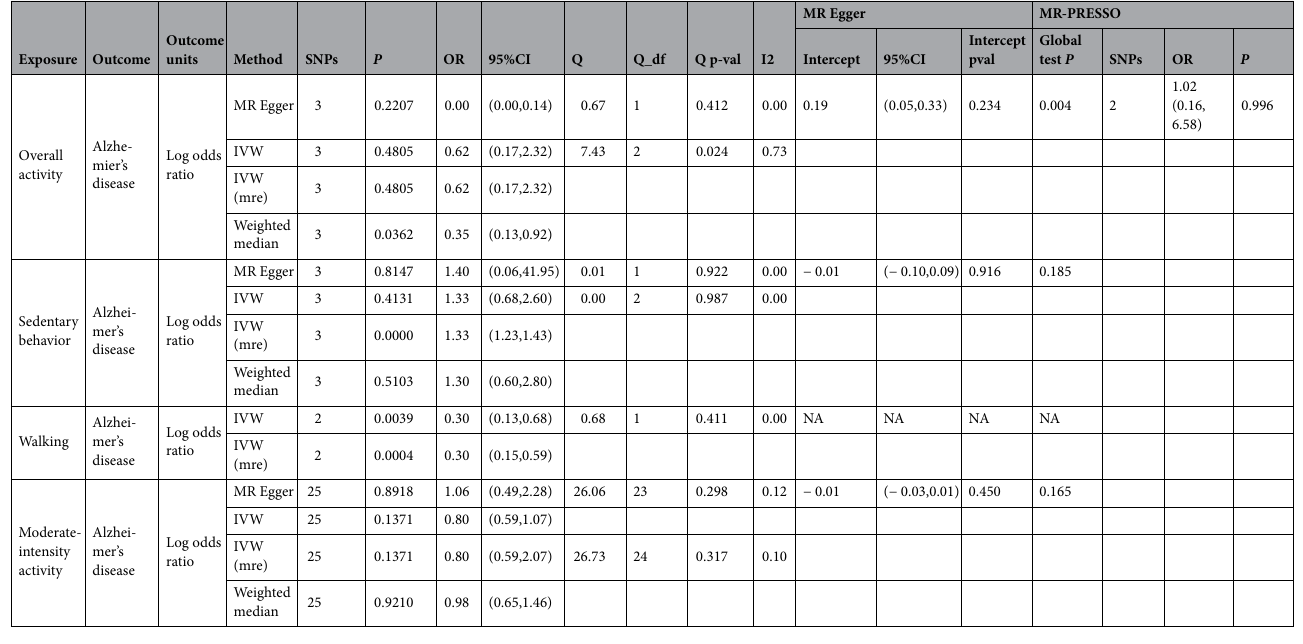
Table 3. MR Estimates for the effects of physical activity on AD risk in IGAP datasets. SNPs, single nucleotide polymorphisms; CI, confidence interval; OR, odds ratio; Q, Cochran Q statistics; IVW, inverse variance weighted; WM, weighted median; MR-Egger, Mendelian randomization-Egger; MR-PRESSO,MR pleiotropy residual sum and outlier. P het : P -values of Cochran’s Q test for heterogeneity were shown. P int : P -values of MR-Egger regression test on the